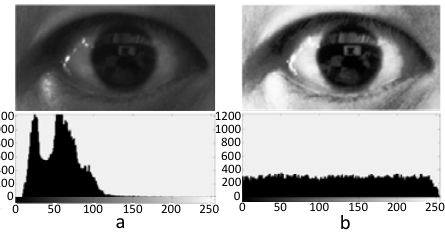
Figure 3: (a) shows the human eye image and gray histogram, (b) shows the human eye image with histogram equalization and gray histogram.